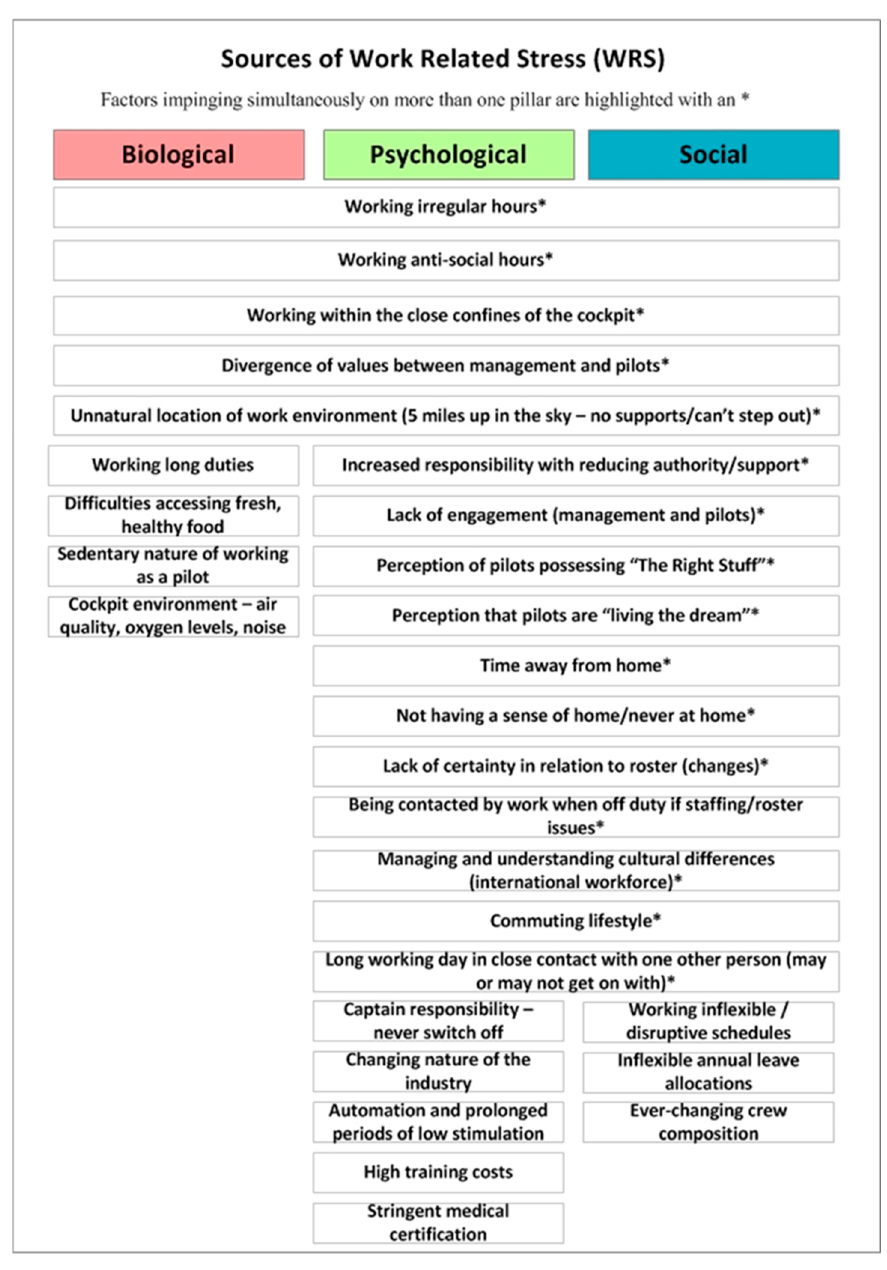
Figure A2. Sources of WRS, Pre COVID-19 (Cahill et al., 2019).